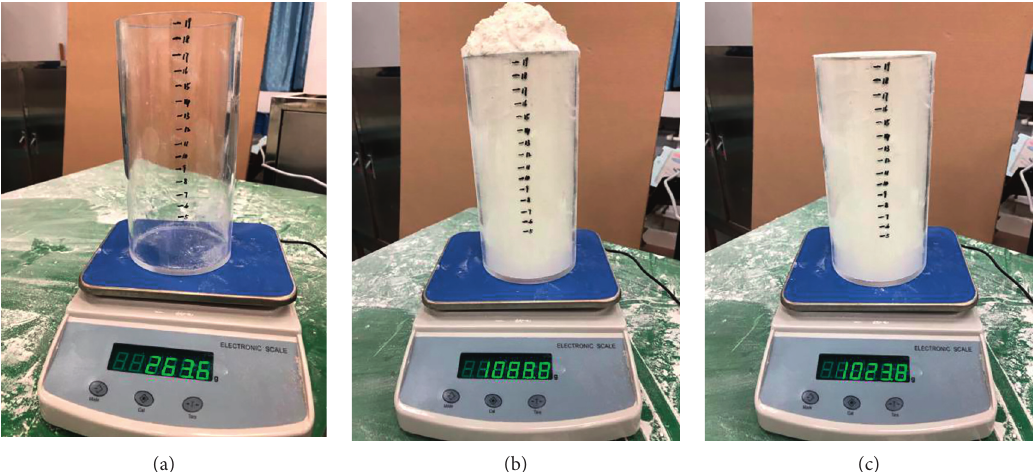
Figure 2: Measurement of wheat flour volume density. (a) Container weight measurement. (b) Pour the flour until it overflows. (c) Measurement of total weight of container and wheat